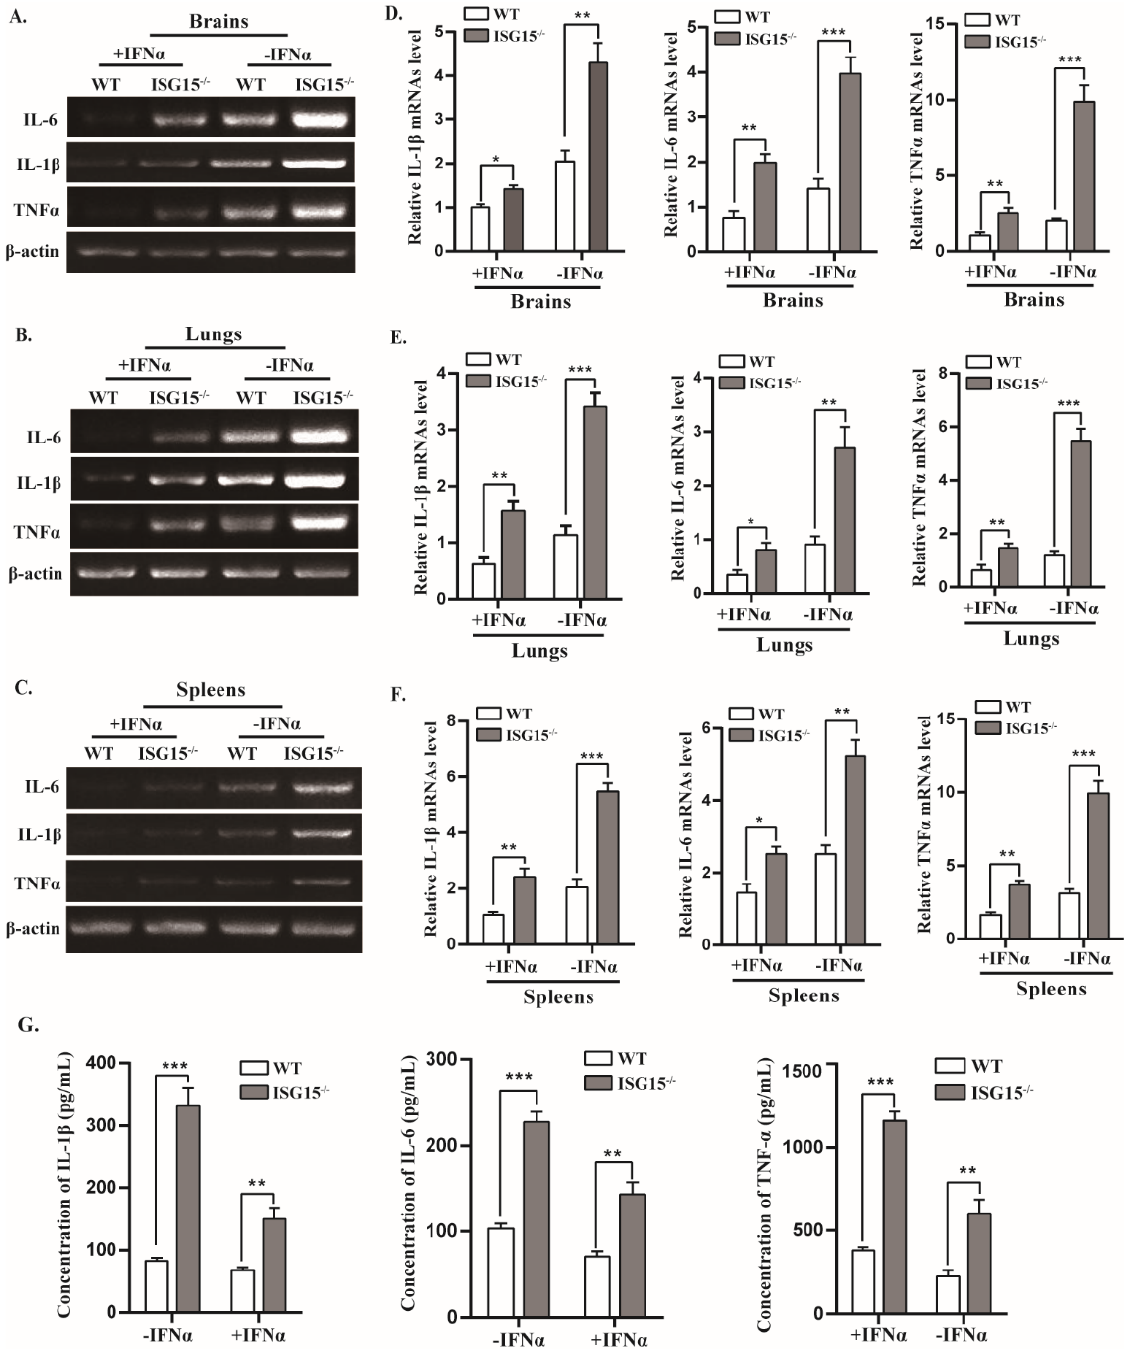
Figure 5. Expression of inflammatory cytokines was significantly increased in infected ISG15 -/- mice. ( A – F ) The RNA levels of IL-1 β , IL-6 and TNF α in the indicated tissues from PRV-infected WT and ISG15 -/- mice by RT-PCR and RT-qPCR, respectively. The data were normalized to β -actin. ( G ) The protein levels were measured by ELISA. * p < 0.05; ** p < 0.01; *** p < 0.001. 3.6. ISG15 Deficiency Potentiates Viral Replication by Blocking STAT1/STAT2 Phosphorylation Because ISG15 deficiency impaired IFN β expression in response to PRV infection, as shown in Figure 3, we speculated that ISG15 may affect IFN β production by targeting phosphorylated STAT1 (pSTAT1) or/and STAT2 (pSTAT2). Therefore, we tested whether ISG15 deficiency affects the expression of pSTAT1 and pSTAT2 in tissues of infected mice by Western blot. We found that the expression of pSTAT1 and pSTAT2 was